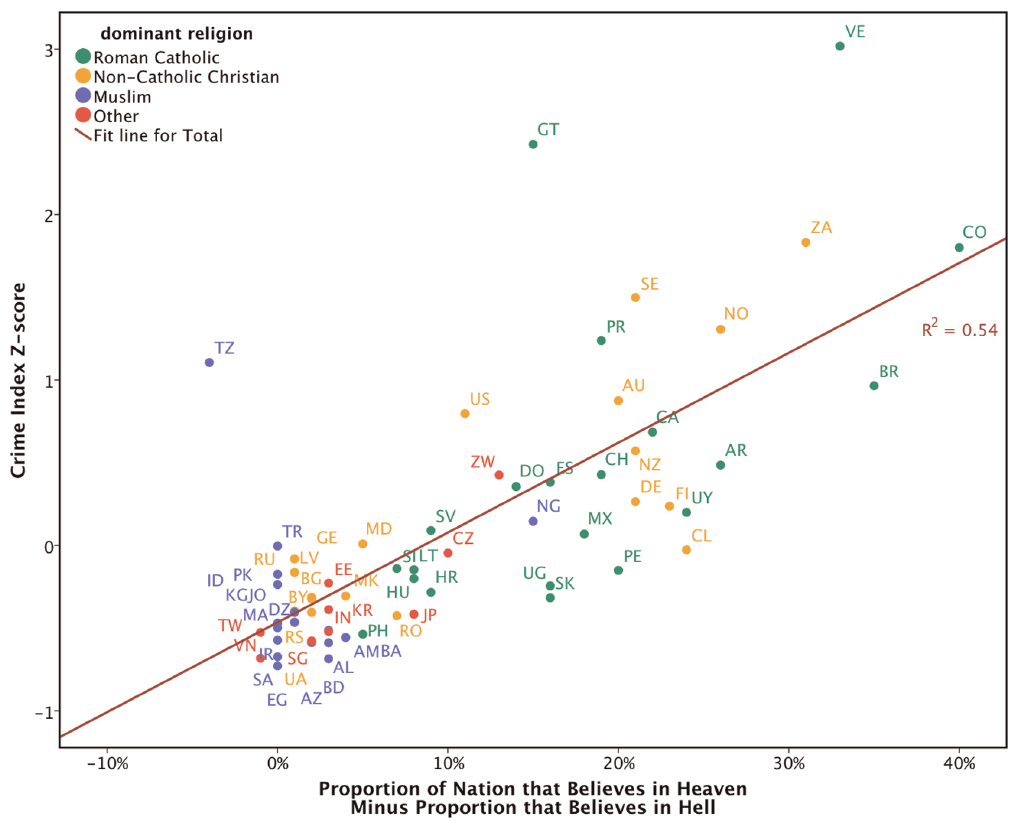
Figure 1. Crime rate z-scores as a function of how much higher the proportion of a nation that believes in heaven is compared to the proportion that believes in hell. R 2 =.54.